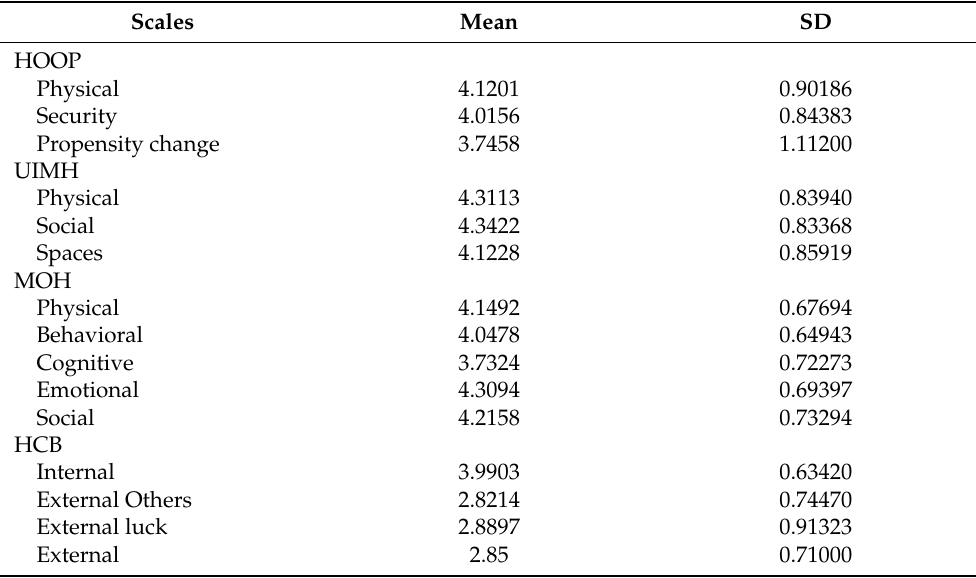
Table 3. Mean and standard deviation of the factors of each